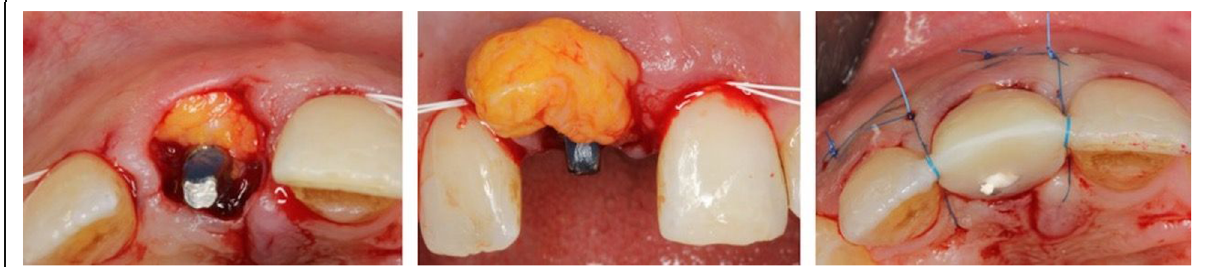
Fig. 2 Clinical illustration of soft-tissue grafting procedure. a , b Connective tissue graft harvested from the hard palate was positioned on the facial aspect via tunneling technique at implant 011. c Occlusal view of the surgical